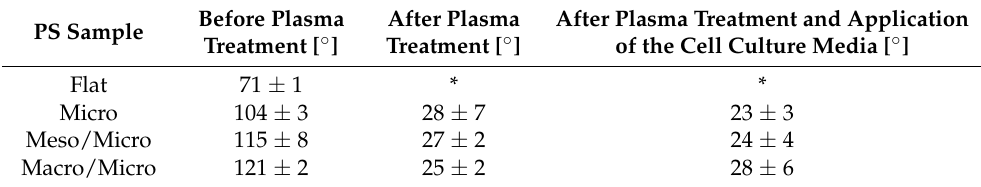
Table 1. Wetting contact angles of compared surfaces with